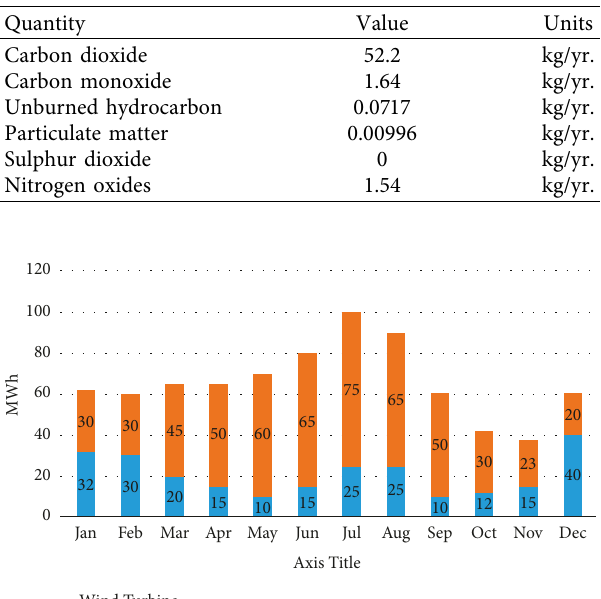
Table 9: Properties data of the system under study for Scenario 3.